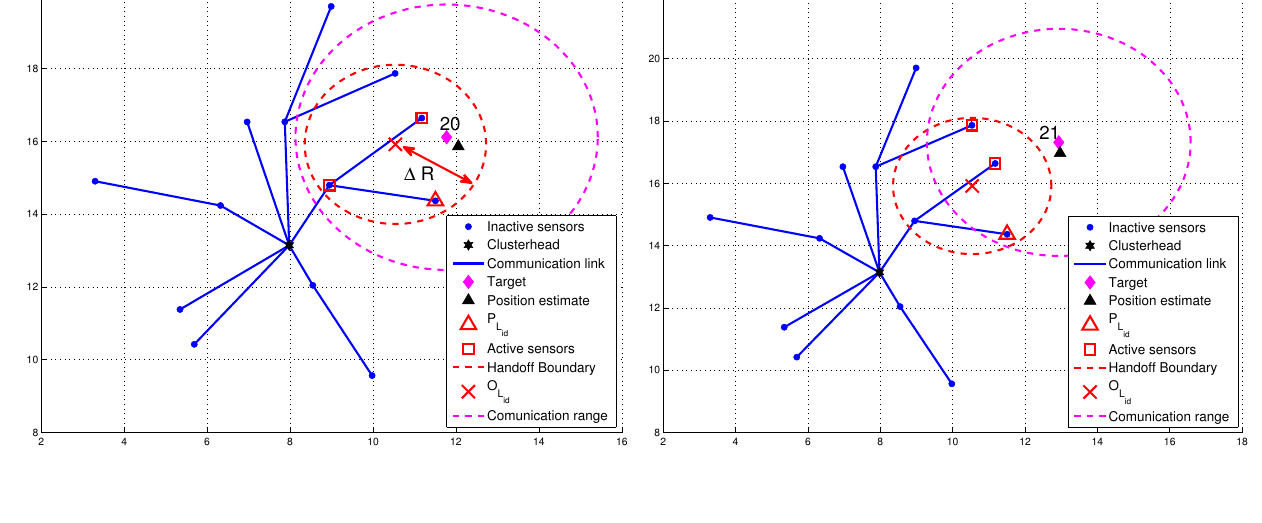
Figure 9. An example of leader handoff